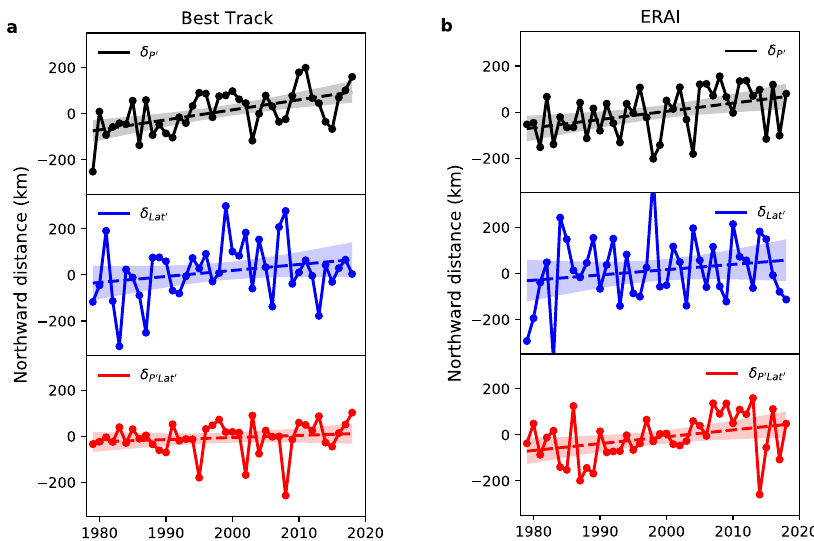
Fig. 3 Changes in three seasonality components of annual-mean latitude of tropical cyclone all-track-points. a Decompositions of annual-mean latitude of all-track-points by three seasonality contributing components, representing the effects of departures (from the respective time means) of monthly relative frequency ( δ P 0 , black), monthly latitude ( δ Lat 0 , blue) and the covariance of the two terms ( δ P 0 Lat 0 , red), respectively, over 1979 – 2018, in the Best Track ensemble mean. b as a , but in the ERA-Interim TC dataset. Dashed lines represent the linear trend, with shading showing 95% con fi dence interval for the linear fi t; the El Niño Southern Oscillation and Paci fi c Decadal Oscillation effects are removed by a multivariate regression; latitude is converted to distance from the equator